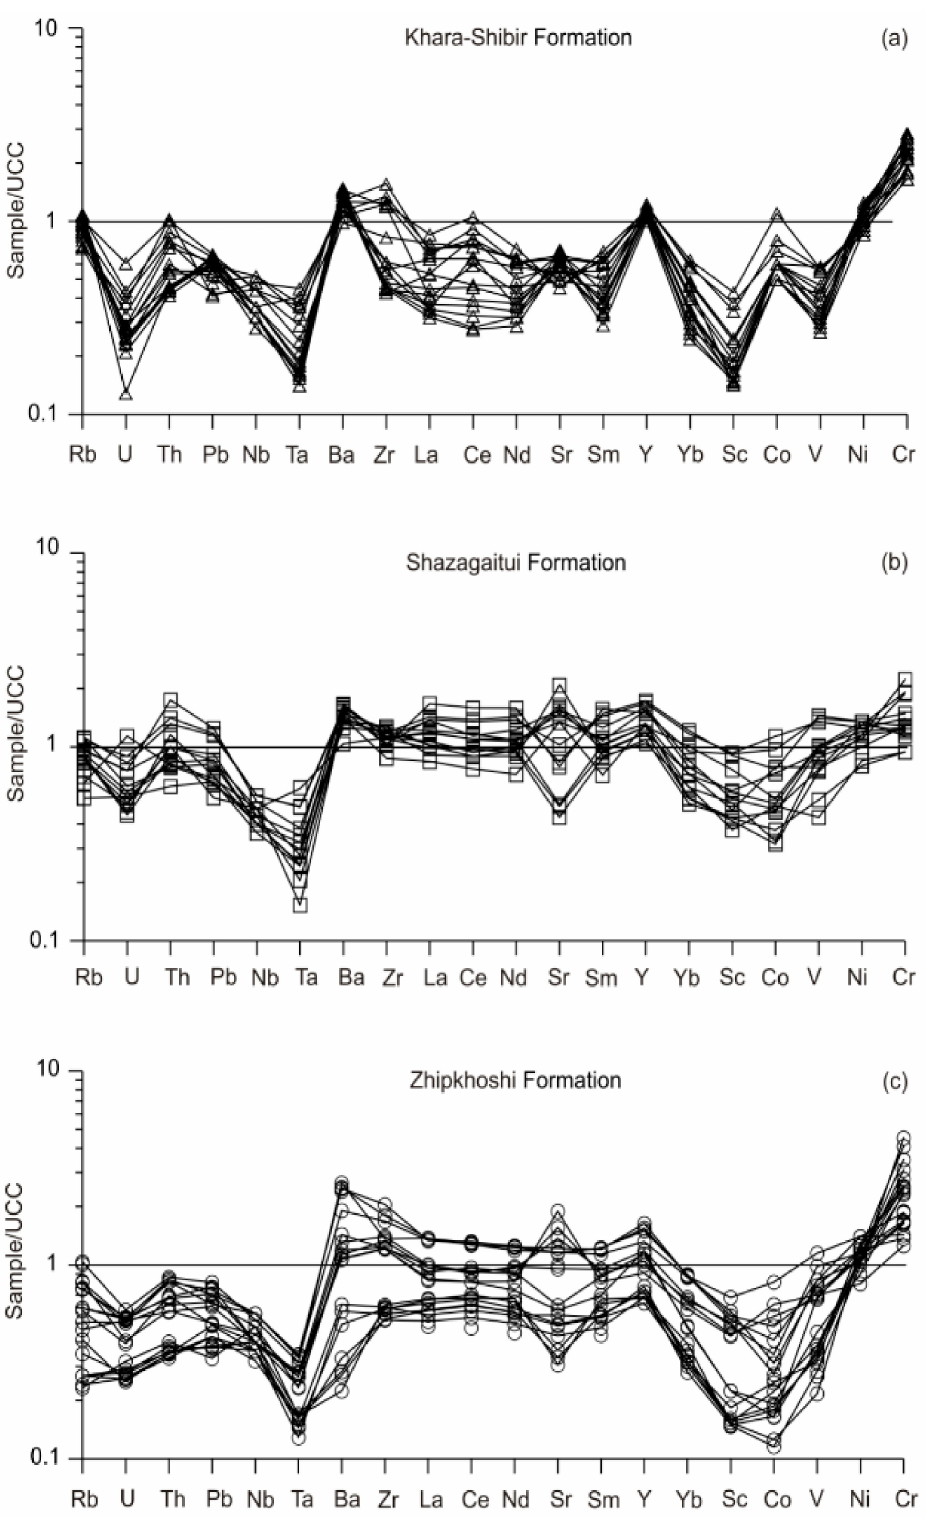
Figure 6. Upper continental crust (UCC)-normalized trace element patterns for siliciclastic rocks of the Chiron Basin. UCC normalizing values are from [49]; ( a ) Khara-Shibir Formation, ( b ) Shazagaitui Formation, ( c ) Zhipkhoshi